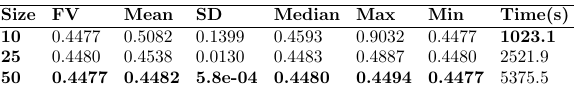
Table 5. Effect of population size